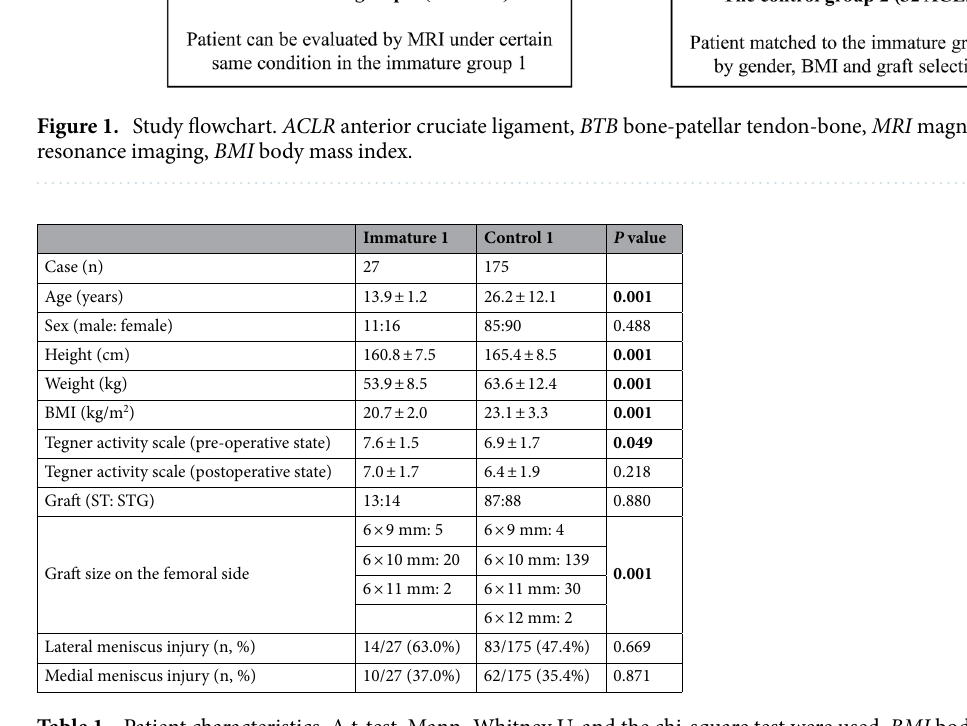
Table 1. Patient characteristics. A t-test, Mann–Whitney U, and the chi-square test were used. BMI body mass index, ST semitendinosus tendon, STG semitendinosus tendon and gracilis tendon. The bold values represent the significant difference, which p values were less than